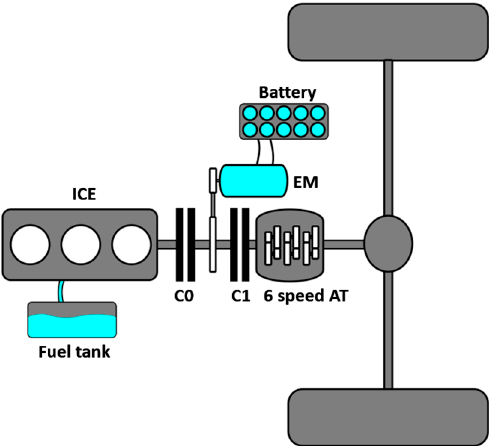
Figure 1. Schematic of the P2 HEV powertrain.